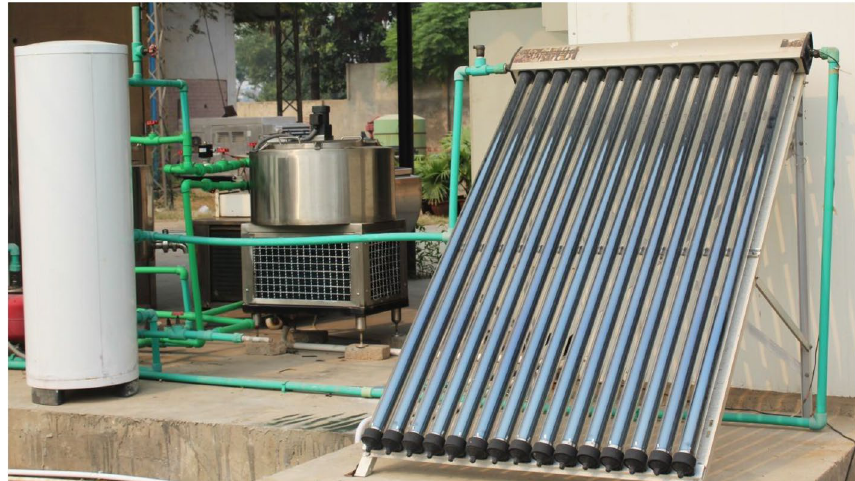
Figure 1. Solar assisted yogurt processing unit 20